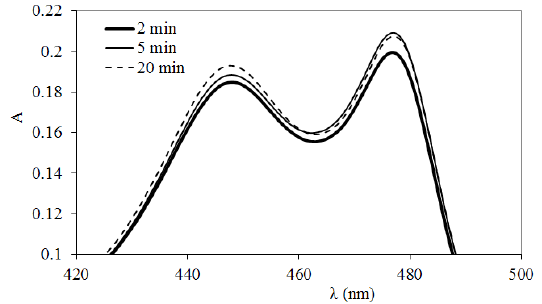
Figure 1. Absorption spectra of Pb(II)-T(DBHP)P-Triton CF-21 complex (0.11 g L -1) after various time from the coloration agent addition (axis scale is chosen to emphasize the wavelength of interest- second